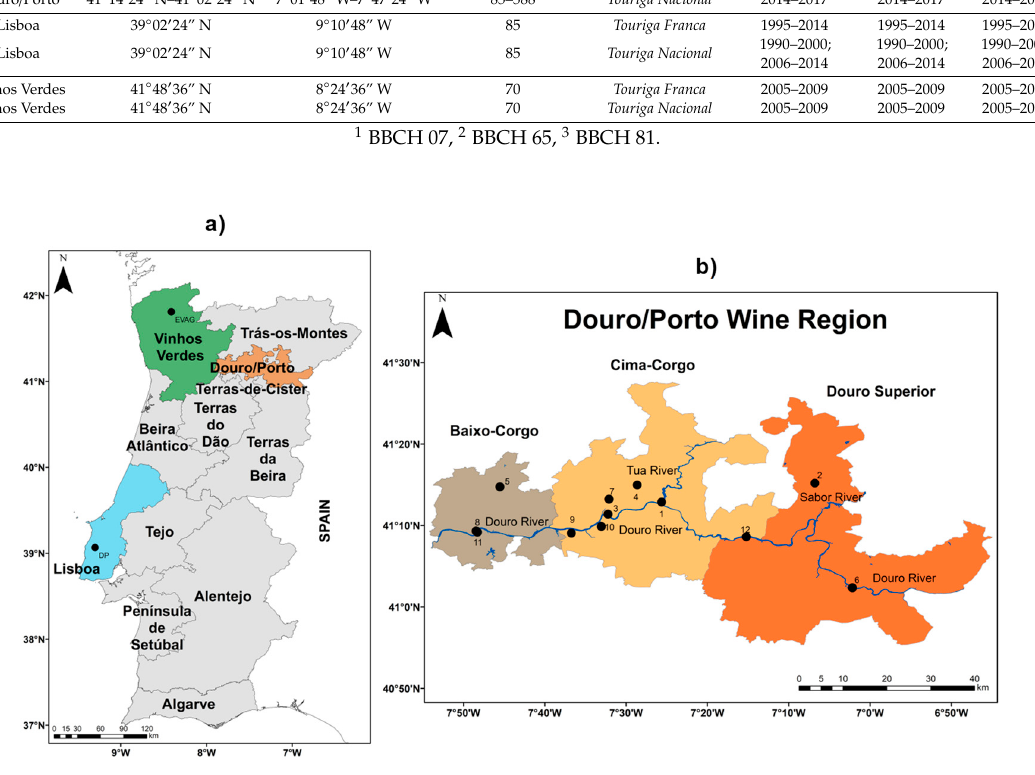
Figure 1. ( a ) Map of mainland Portugal with wine regions’ boundaries. The three wine regions providing phenological data to the present study are grey shaded (Vinhos-Verdes, Lisboa, and Douro/Porto). The location of the vineyard sites EVAG, in Vinhos-Verdes wine region, and DP, in Lisboa wine region, are also outlined. ( b ) Douro/Porto wine region and its sub-regions ( Baixo-Corgo , Cima-Corgo, and Douro Superior ), along with the geographical locations of the 12 vineyard sites. The main rivers are also plotted, including the Douro River.